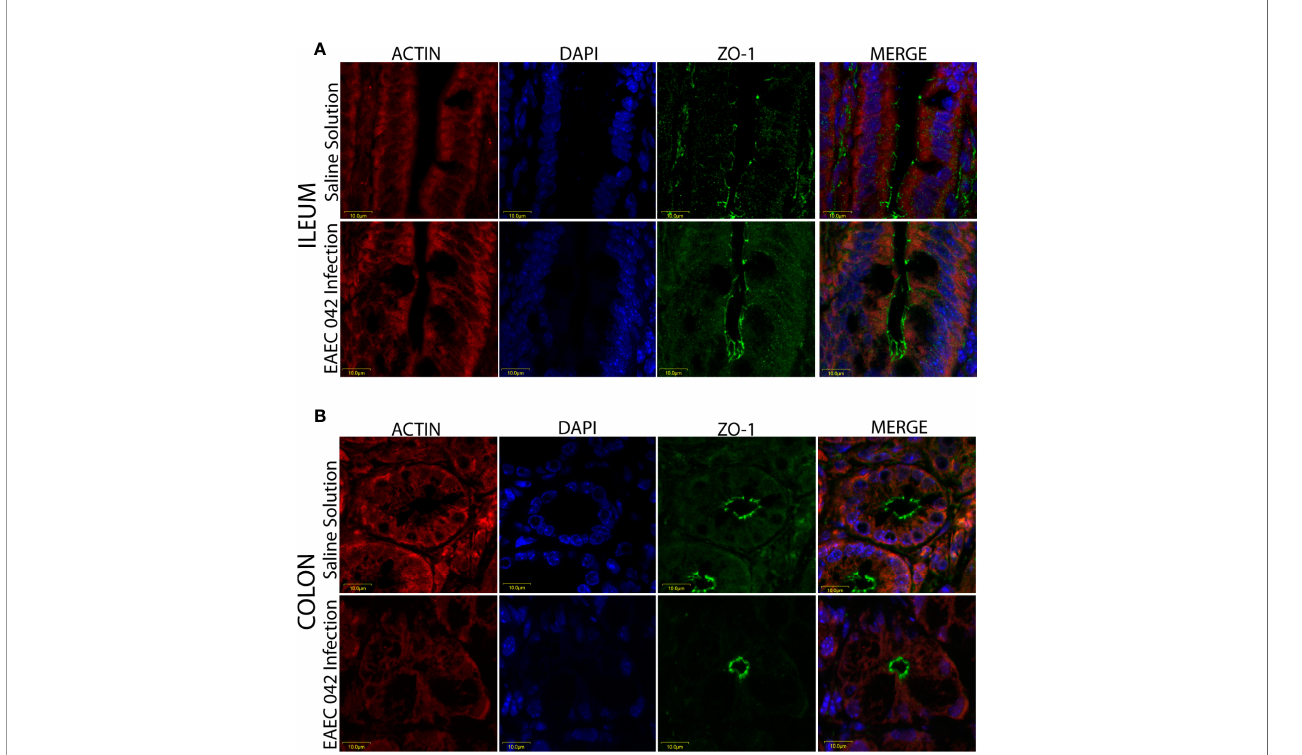
FIGURE 5 | Immuno fl uorescence of the tight junction protein ZO-1 at 7 days post-infection. (A) Ileum of mice with EAEC 042 infection and control mice with Saline Solution. (B) Colon of mice with EAEC 042 infection and control mice with Saline Solution. ZO-1 was stained with a secondary antibody conjugated with Alexa 480 antibody (green), actin with an F-actin probe Alexa 568 phalloidin (red), and nucleic acids with DAPI